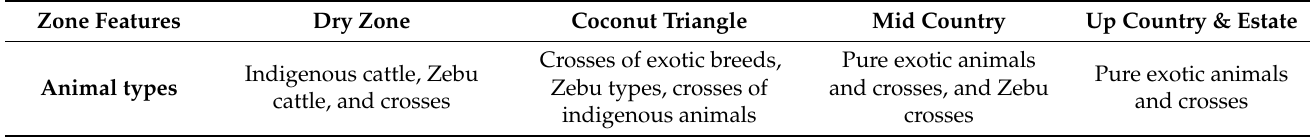
Table 1. Milk production zones in Sri Lanka (after